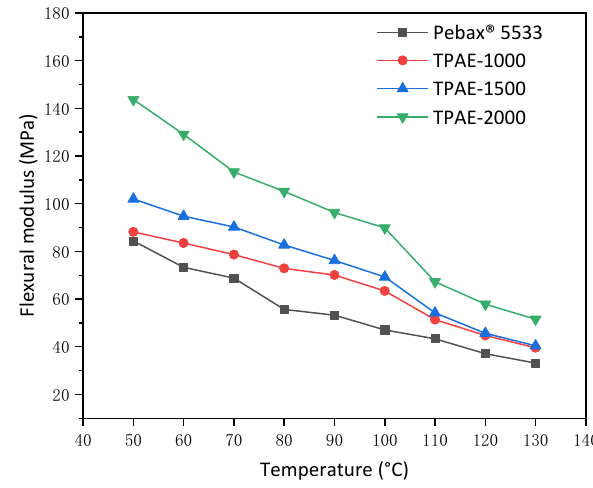
Figure 7. High temperature bending test results.